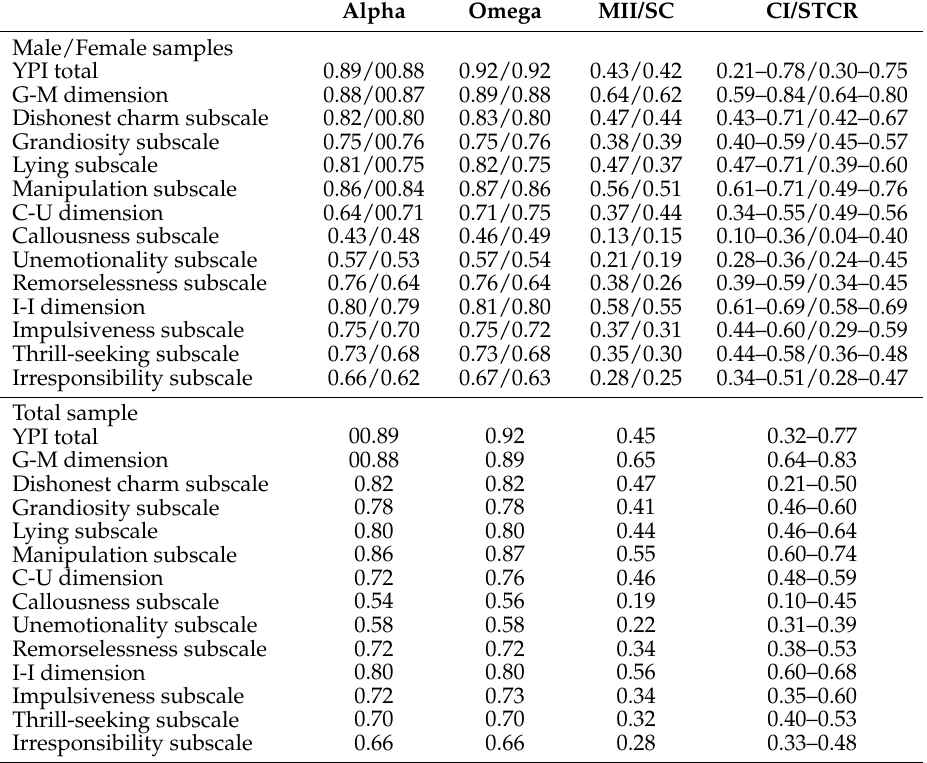
Table 4. Cronbach’s alpha and omega coefficients, mean inter-item correlations, and corrected item-total correlations range for the YPI and its dimensions and